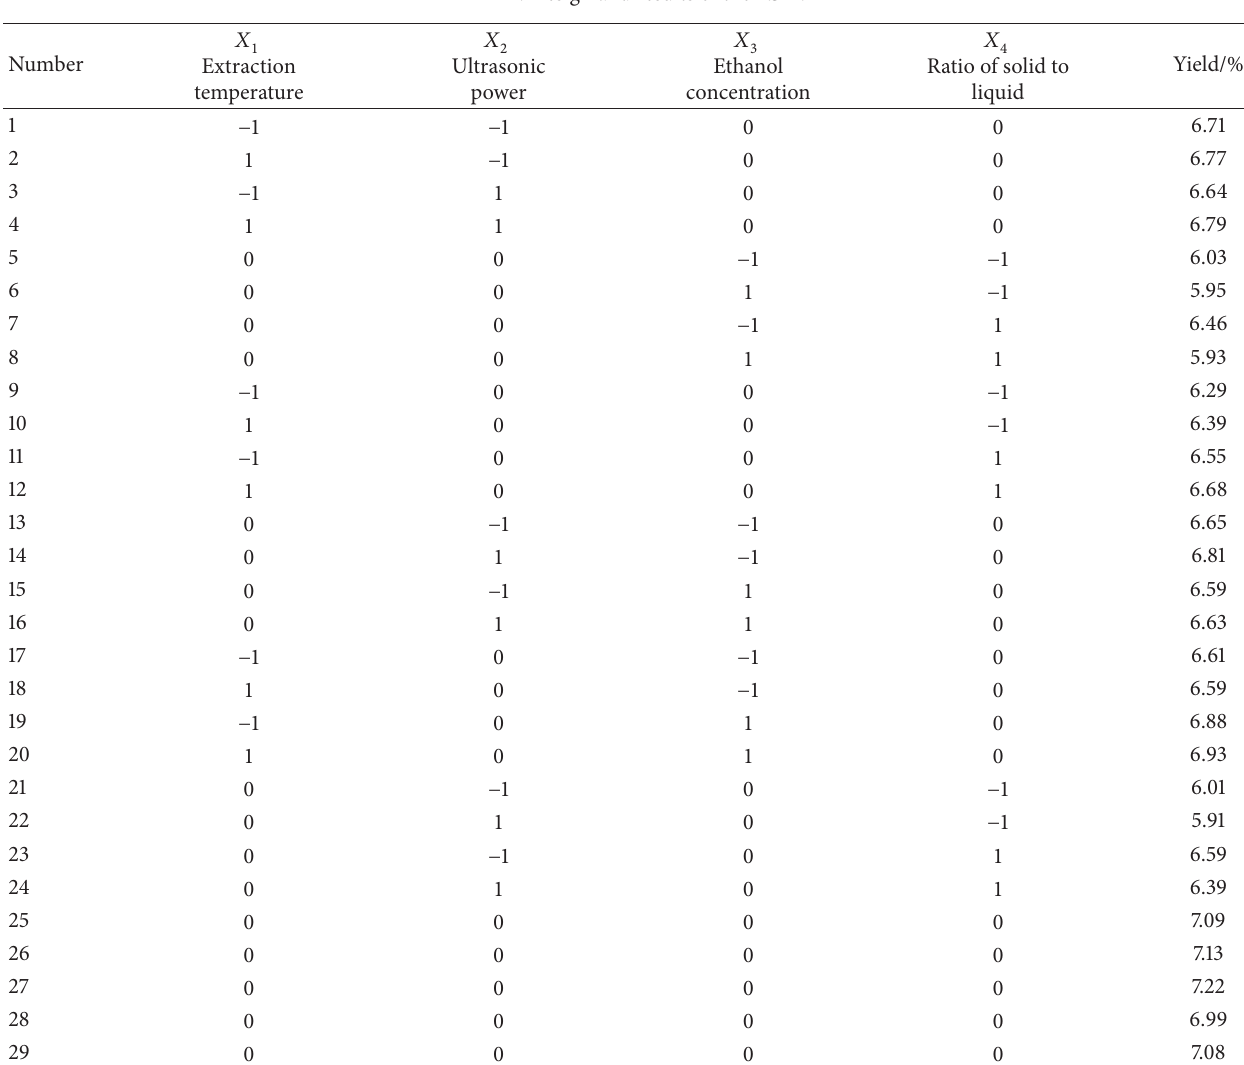
Table 2: Design and results of the RSM.